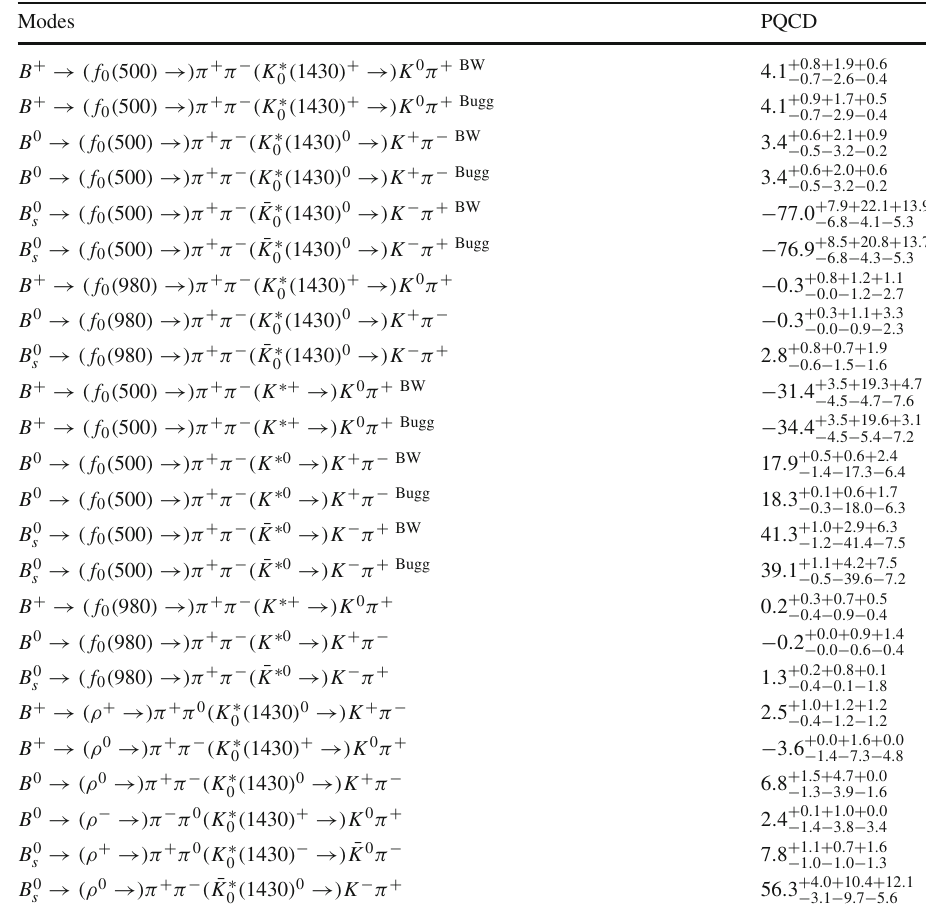
asymmetries (in units of %) for the four-body B → [ SS , SV , V S ] → (ππ)( K π) decays, with S = [ f ( 500 ), f ( 980 ), K ∗ ( 1430 ) ] 0 0 0 and V = [ ρ, K ∗ ] . The sources of the theoretical errors are the same as in Table 4